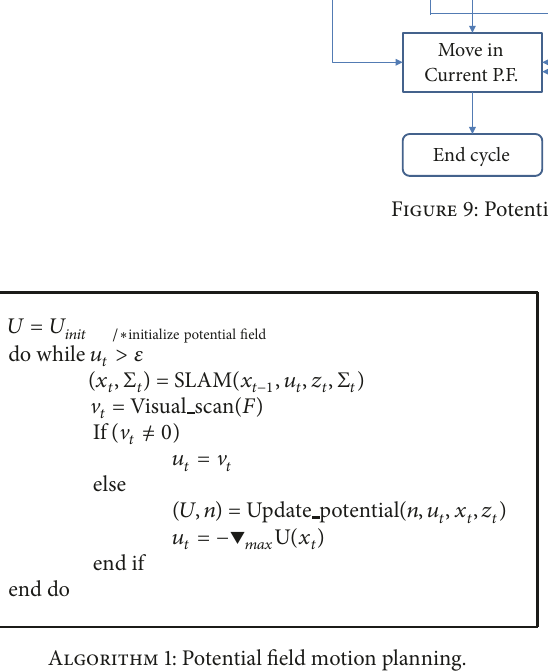
Algorithm 1: Potential field motion planning.